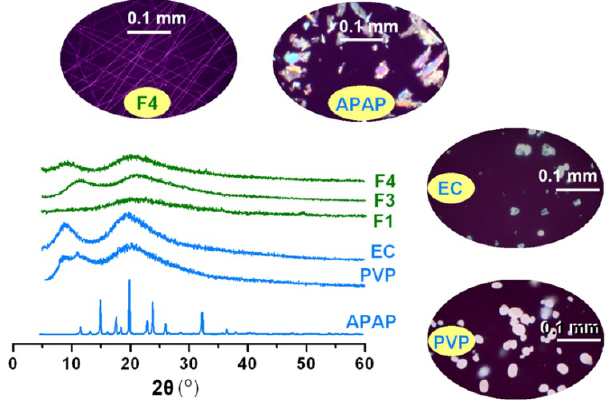
Figure 4. Physical status characterization: XRD patterns of the raw materials (ethyl cellulose (EC), poly(vinyl pyrrolidone) (PVP), and acetaminophen (APAP)) and the drug-loaded nanofibers: F1 (prepared by single fluid electrospinning), F3 and F4 (prepared by coaxial